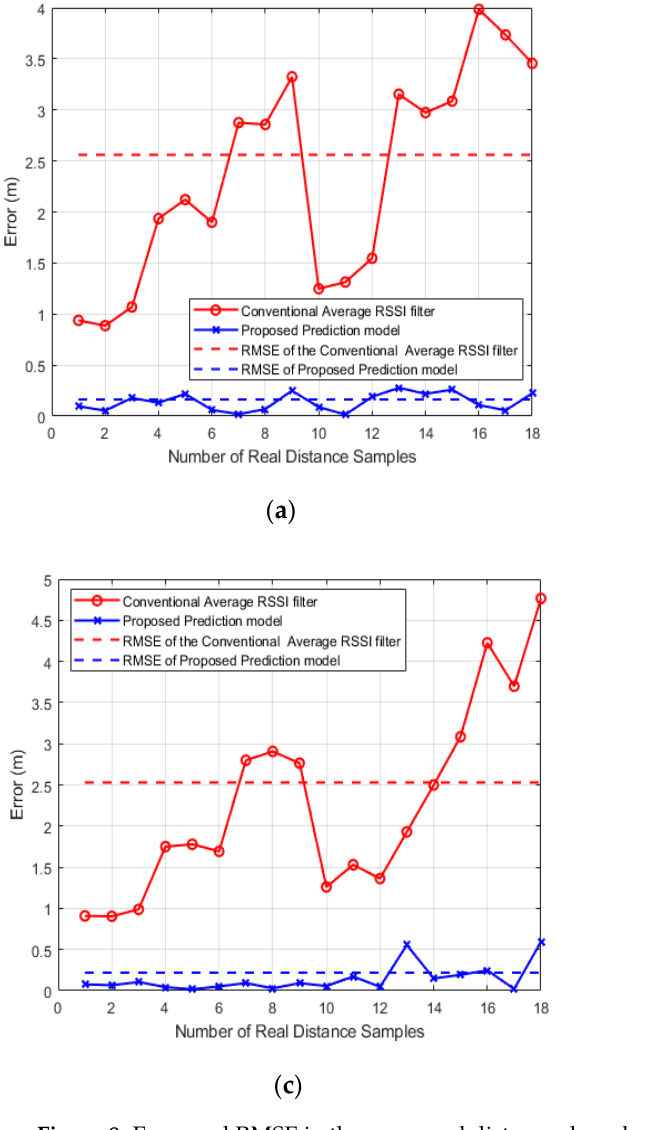
Figure 8. Error and RMSE in the measured distances based on RSSI average filter vs. Proposed RSSI distance prediction model at: ( a ) Beacon 1 (B1); ( b ) Beacon 2 (B2); ( c ) Beacon 3 (B3); ( d ) Beacon 4 (B4).